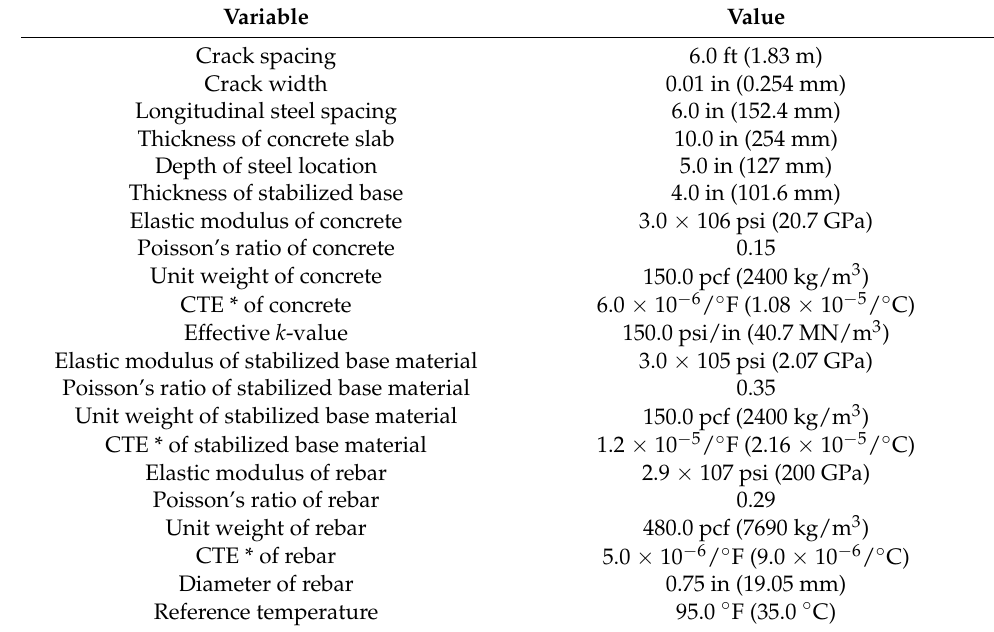
Figure 6. ( a ) Continuously reinforced concrete pavement (CRCP) FE model; ( b ) subgrade behavior; ( c ) friction behavior; ( d ) transverse crack behavior; and ( e ) bond-slip behavior. Table 8. Input variables and control values for CRCP FE analysis.